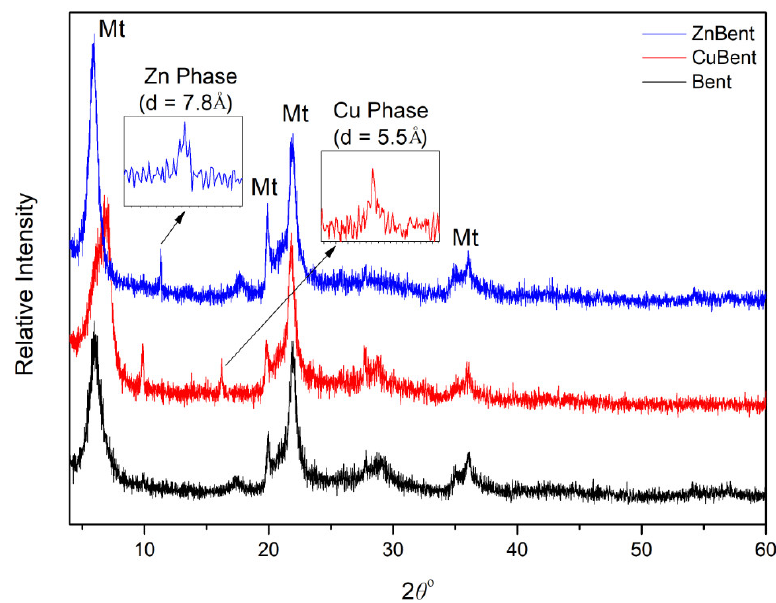
Figure 1. X-ray diffraction patterns of Unmodified Bentonite (Bent), Zinc Modified Bentonite (ZnBent), and Copper Modified Bentonite (CuBent). (Legend: Mt: Montmorillonite, Zn Phase: Si- monkolleite syn, Cu Phase: Copper chloride hydroxide).